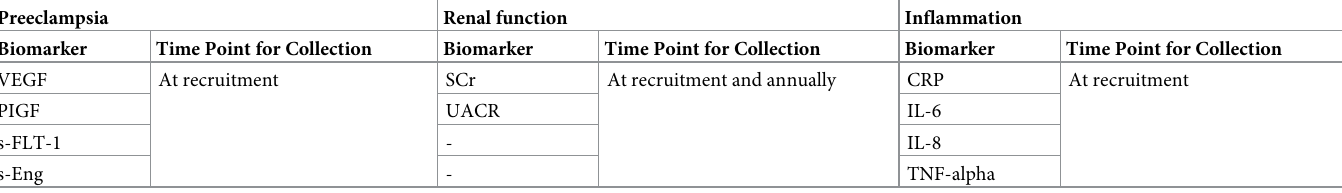
Table 2. Biomarkers and time points for collection.